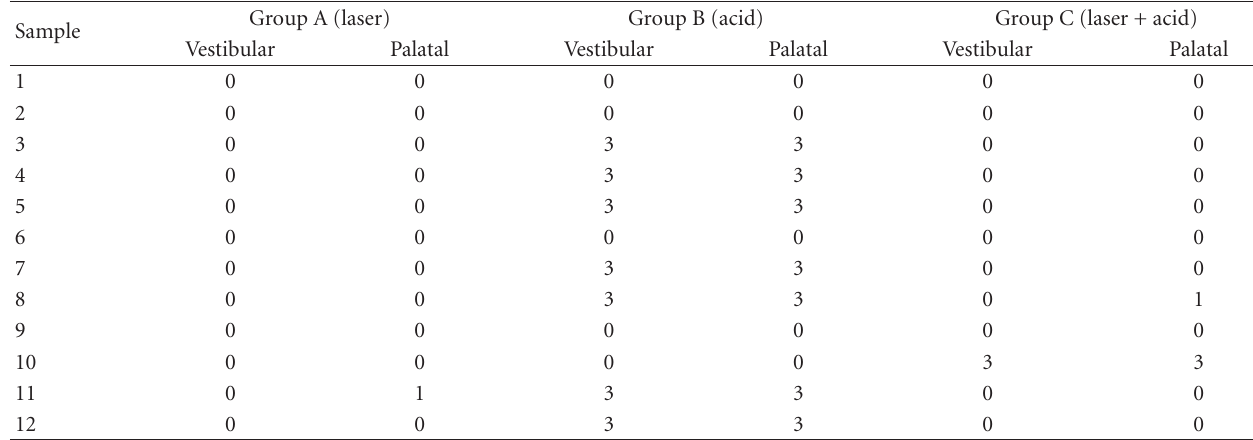
Table 4: Results obtained by the infiltration